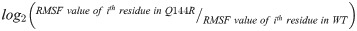
MD simulation analysis of the Q144R and wild type CYP1B1 structure.Panel A shows the distribution of the first three major principal components of the Q144R and wild type (WT) structures. The distributions are observed to be different, suggesting an altered functional motion in the Q144R mutant. Panel B shows the altered flexibility pattern of the Q144R mutant as compared to WT. The log2 ratio is calculated as log2(RMSF value of ith residue in Q144RRMSF value of ith residue in WT). Therefore a positive value indicates an increase in flexibility in the Q144R mutant and a negative value indicates a decrease in flexibility as compared to WT CYP1B1. The Q144R mutant has a significantly altered flexibility pattern within the C-D, F and G'-H block region, shown separately in the right hand side of the panel. Panel C shows the altered tunnels in two different orientations (top and bottom view) of the Q144R and WT CYP1B1 structures. The upper panel of "Tunnel properties" shows the radius (in bar plot) and length (in black line) of the tunnels (top view orientation) in the mutant (blue) and WT (green) structures. The lower panel shows the similar properties of the tunnels observed in the bottom view orientation. Panel D shows docked retinol in the WT and mutant CYP1B1 structures. The panel also shows an overall decrease in binding energy in retinol binding for the mutant protein, observed through MD simulation.